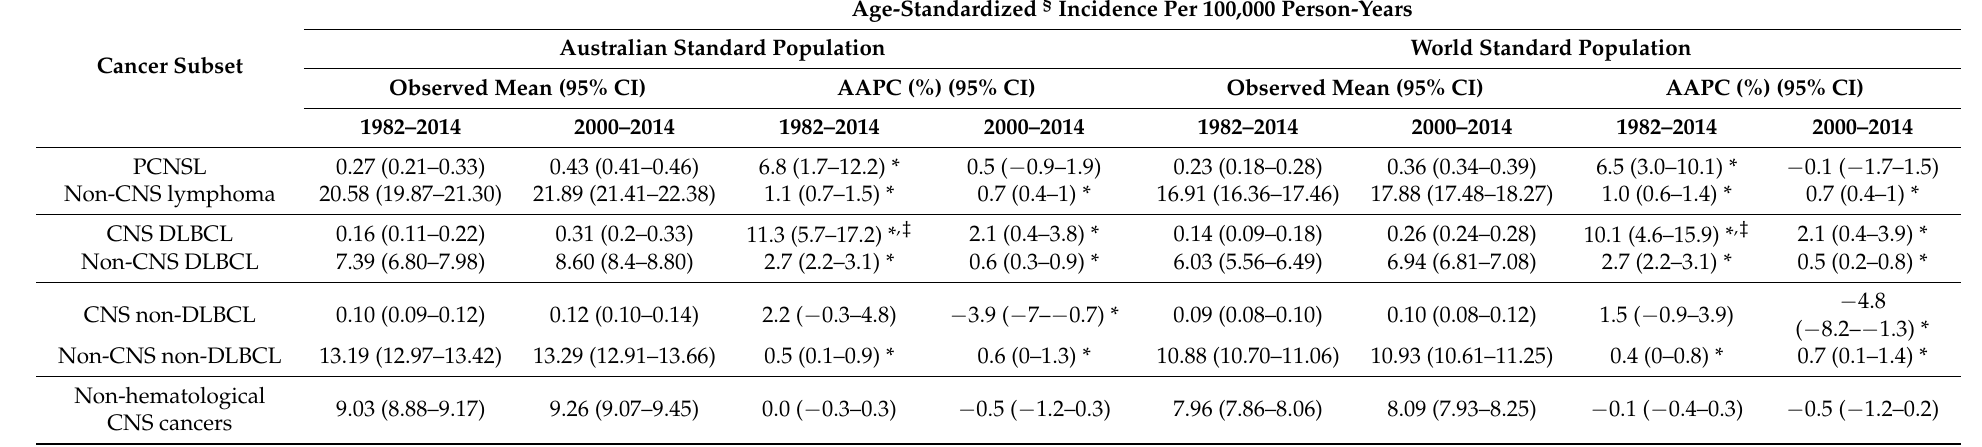
Table 2. Age-standardized incidence rates and trends for CNS and non-CNS lymphomas, and non-hematological CNS cancers in Australian adults between 1982 and 2014.